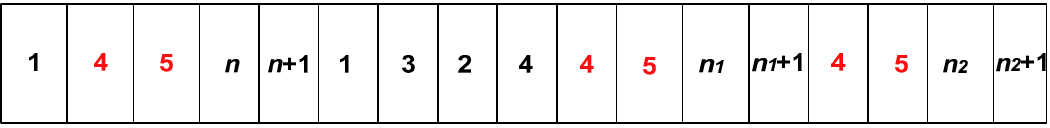
Figure 5. Example of cluster label sequence.